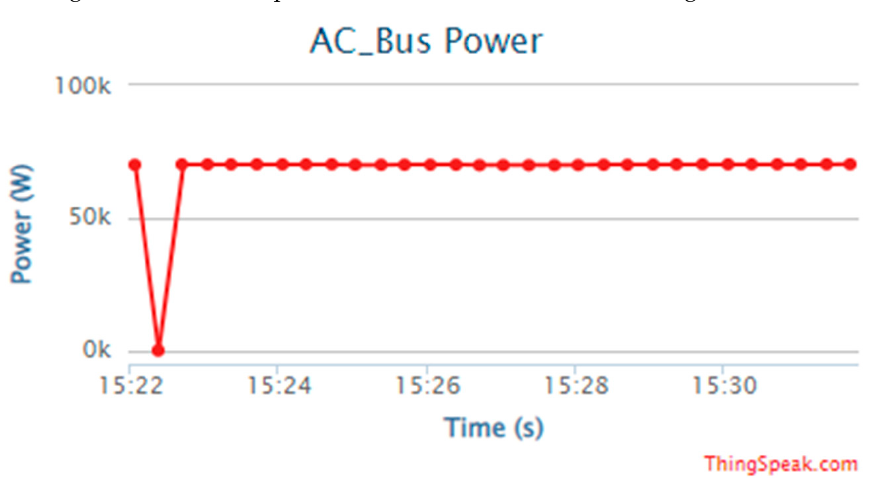
Figure 16. Measured power at the AC bus.